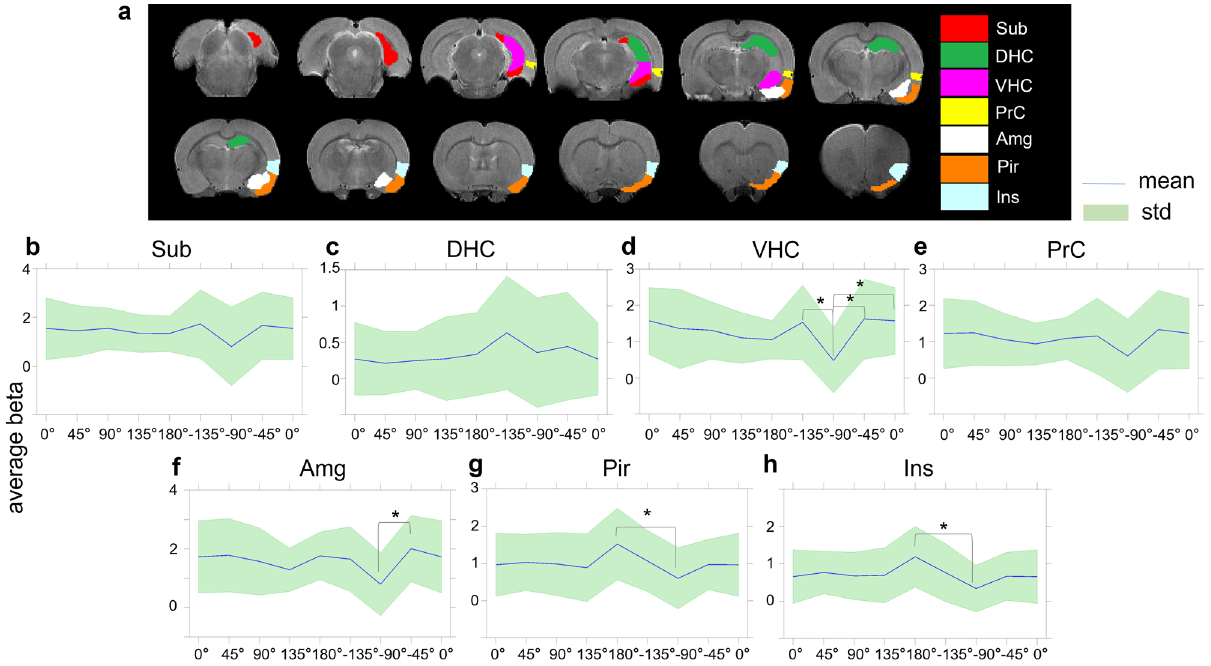
Figure 3. ROI analyses of OS-DBS in the right EC (n = 10). The locations of the primary ROIs are shown on T2-weighted MRI images ( a ). Average beta values are shown for the ROI in the subiculum, Sub ( b ); dorsal hippocampus, DHC ( c ); ventral hippocampus (VHC) (d) ; perirhinal cortex, PrC ( e ); amygdala, Amg ( f ); piriform cortex, Pir ( g ); and insula, Ins ( h ). The blue line and green area represent the mean value and standard deviation among rats, respectively. *p < 0.05, corrected (linear mixed model comparisons vs −90°, adjusted for Bonferroni multiple comparisons correction). Coronal brain images are displayed in neurological convention (left corresponds to the left side of the brain). Stimulation frequency was 20